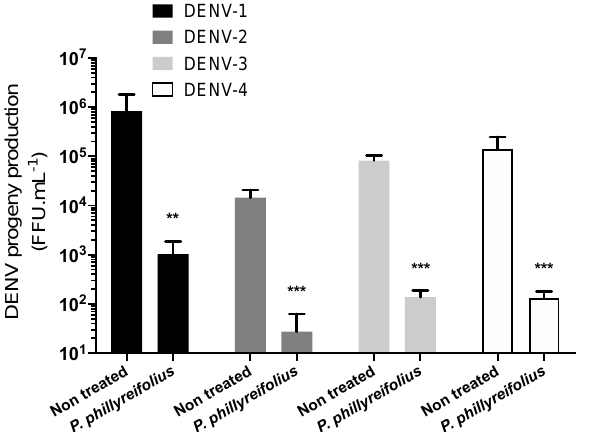
Figure 2. Phyllanthus phillyreifolius extract inhibits infection of four dengue virus (DENV) serotypes in Huh7.5 cells. Huh7.5 cells were infected for 48 h with DENV at different MOI 0.2, 2, 0.5, and 2 for DENV 1-4, respectively, with or without P. phillyreifolius (250 µ g / mL). The virus progeny production was titrated in C6 / 36 cells using a foci-forming immunodetection assay. Data represent the means ± SD from three independent experiments performed in duplicate. ** p <0.01; *** p <0.001, **** p <0.0001, n.s. = not significant.